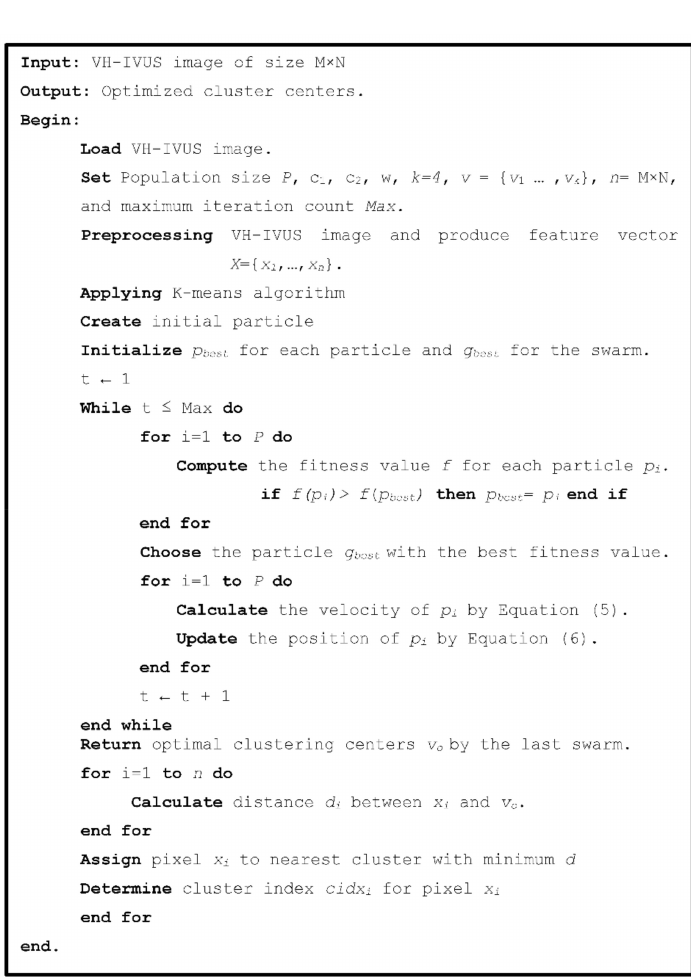
Figure 4. Pseudo-code of the KMPSO model.